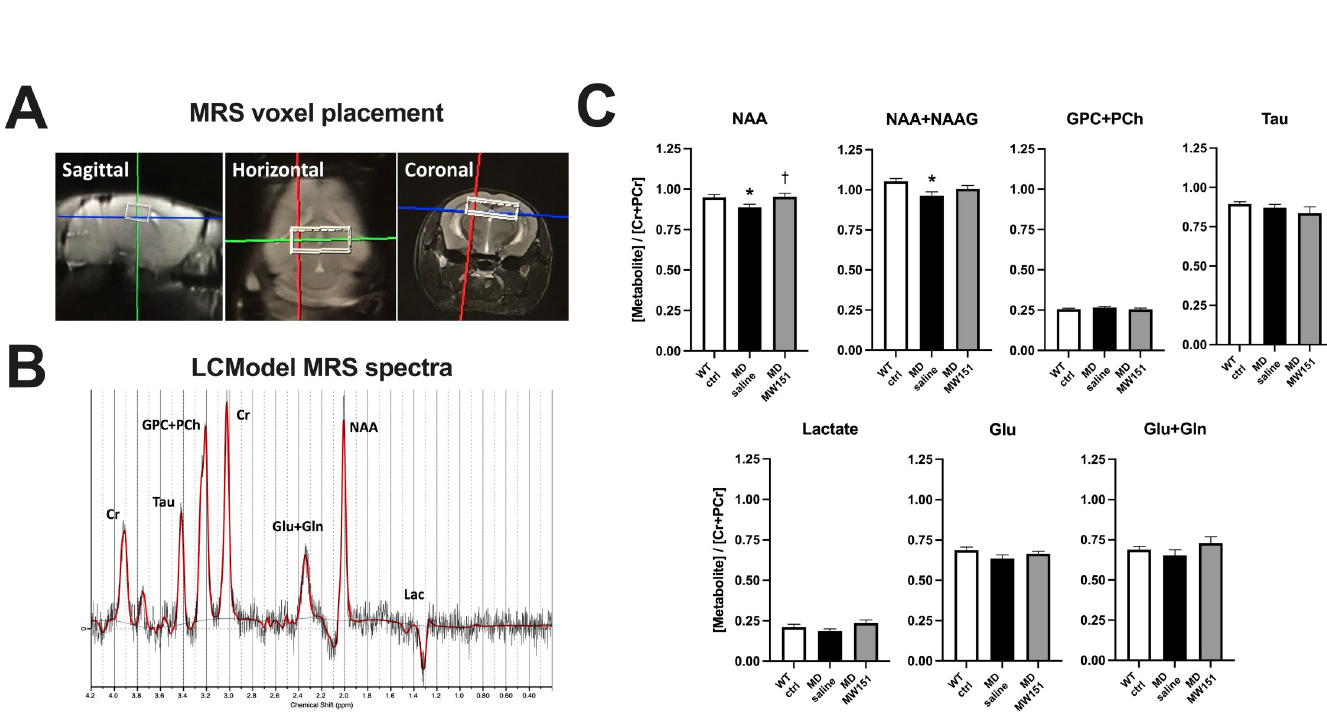
Fig 4. Hippocampal NAA/creatine ratio is fully restored in MD mice after treatment with MW151. ( A ) Example voxel placement over the bilateral hippocampus is shown from sagittal, horizontal, and coronal perspectives. ( B ) An example of the MRS spectra output from LCmodel is shown. ( C ) Metabolites expressed as a ratio to total creatine concentration (Cr+PCr) are shown. Results of one-way ANOVAs indicated significant differences in average NAA ratio ( F (2, 27) = 3.550, p = .0428) and NAA+NAAG ratio ( F (2, 27) = 4.4189, p = 0.026), with Holm-Sidak post hoc tests showing decreases in the MD saline but not MD MW151 groups, � p < .05 versus WT ctrl, †p < .05 versus MD